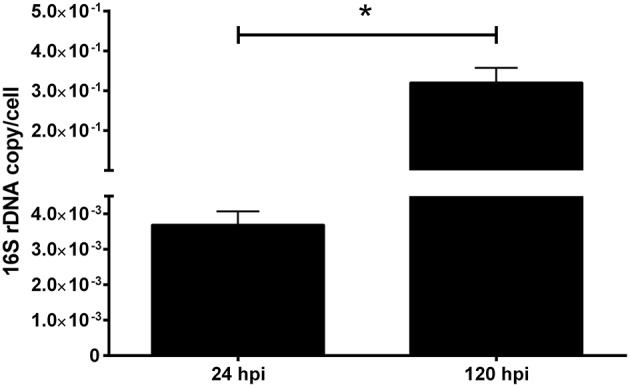
16S rDNA quantification of P. salmonis infecting macrophage-enriched cell cultures. Macrophage-enriched cultures obtained from Atlantic salmon head kidneys were incubated with P. salmonis-FITC at a MOI of 0.5 bacteria/cell in L-15 supplemented medium. The coding gene of the ribosomal 16S subunit was quantified at 24 and 120 hpi to indirectly evaluate the bacterial proliferation. The data (mean ± SEM) were normalized to the number of cells per sample. The statistical analysis was performed using Student's t-test with a Mann–Whitney post-statistical test. Significant difference: *p < 0.05.